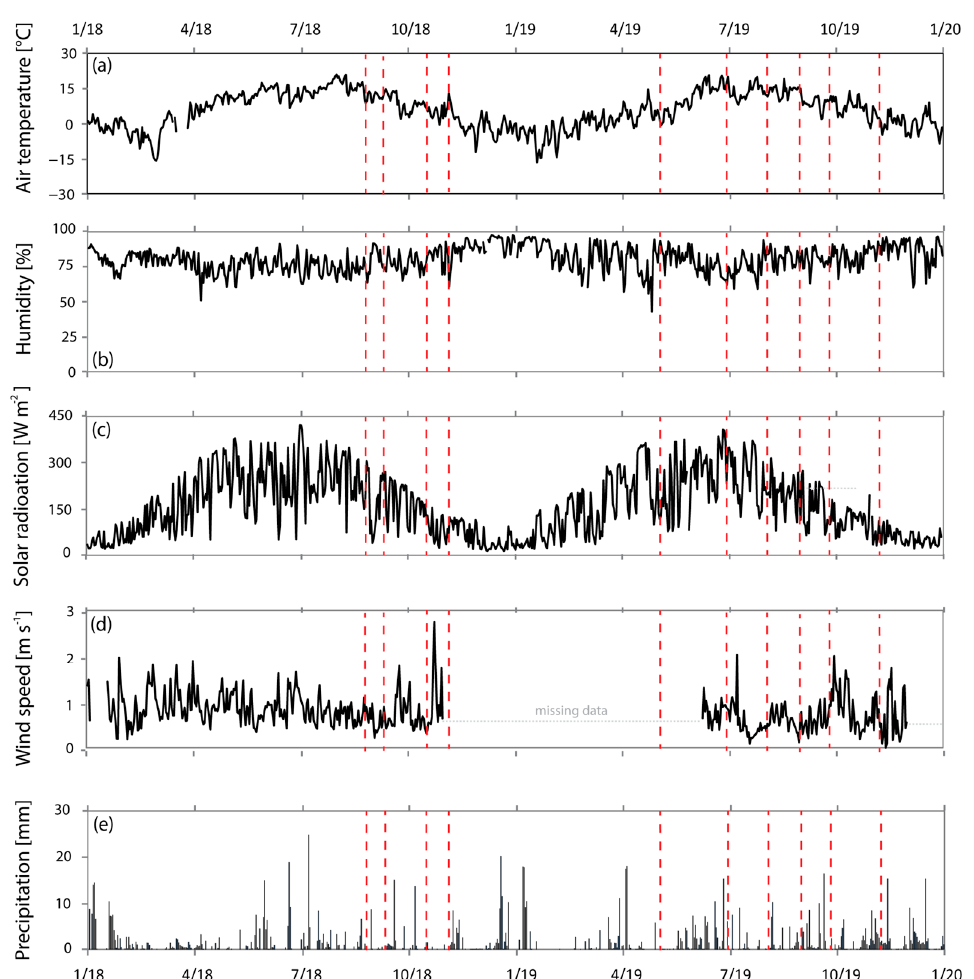
Figure 2. Results of the field hydrograph monitoring ( a ) air Temperature [°T], ( b ) humidity [%], ( c ) solar radiation [W m-3], ( d ) wind speed [m s-1], and ( e ) precipitation [mm]. Red dashed lines represent the days of fieldwork.